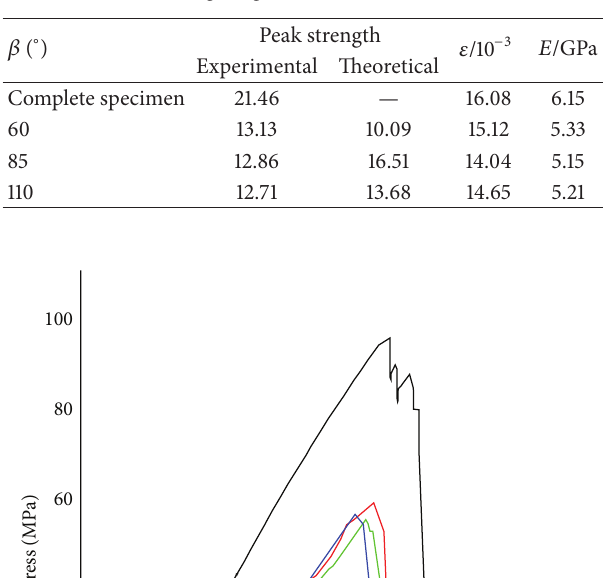
Table 1: Mechanical parameters of specimens with preexisting cracks of different bridge angles.